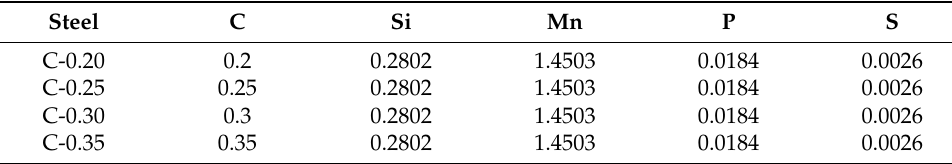
Table 5. Chemical compositions (mass%) of simulated steel.